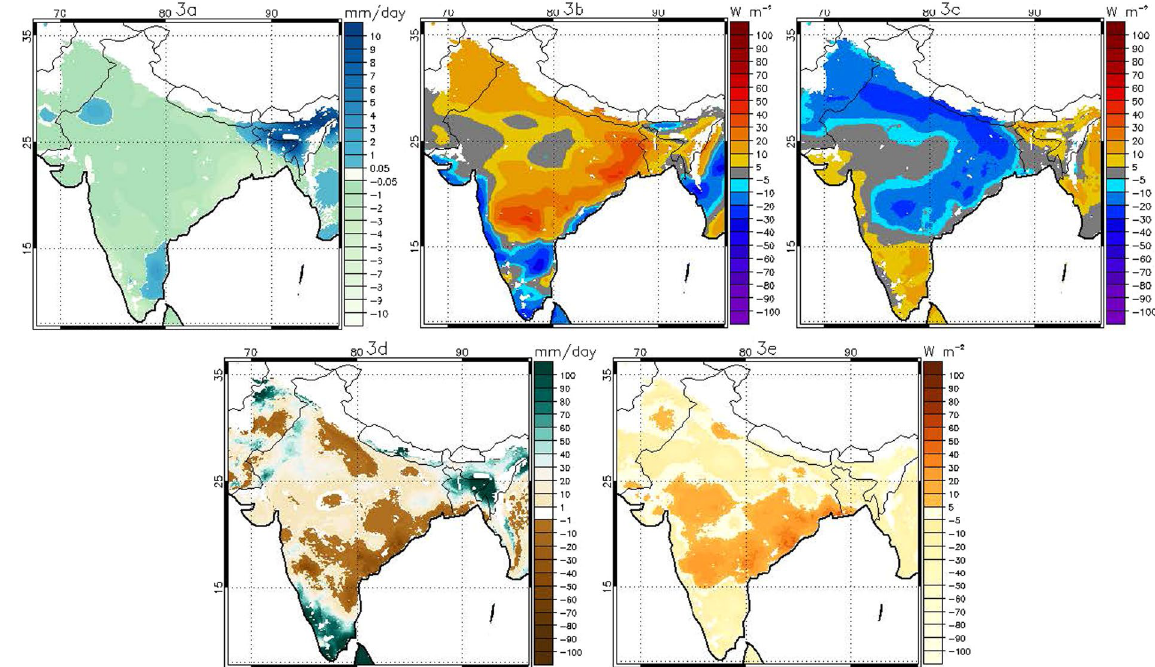
Figure 3. Anomalies of ( a ) total precipitation, ( b ) Net SW, ( c ) Net LW, ( d ) total profile soil moisture and ( e ) SH for the week of May 21 st − 22 nd to May 27 th − 28 th in 2015 based on the weekly climatology of 1980–2015. Any pixel with elevation above 1000 m is not shown (white colored region). Data visualizations produced using IDL [8.4] (Exelis Visual Information Solutions, Boulder, Colorado).